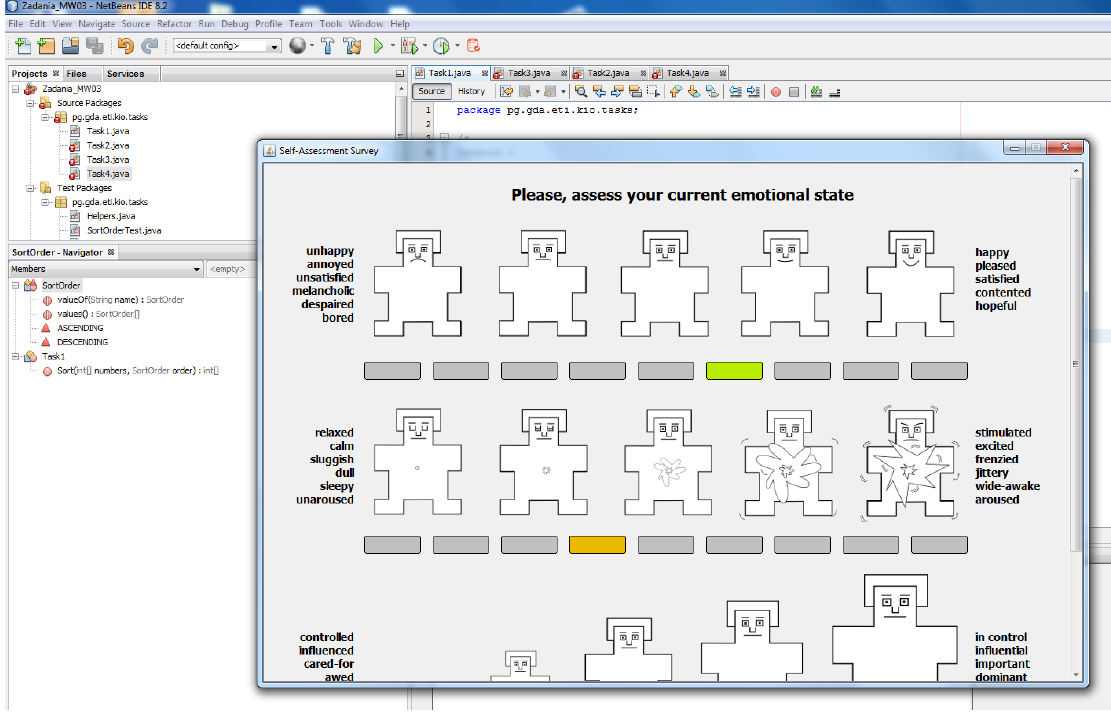
Figure 2. Self-Assessment Manikin used during the